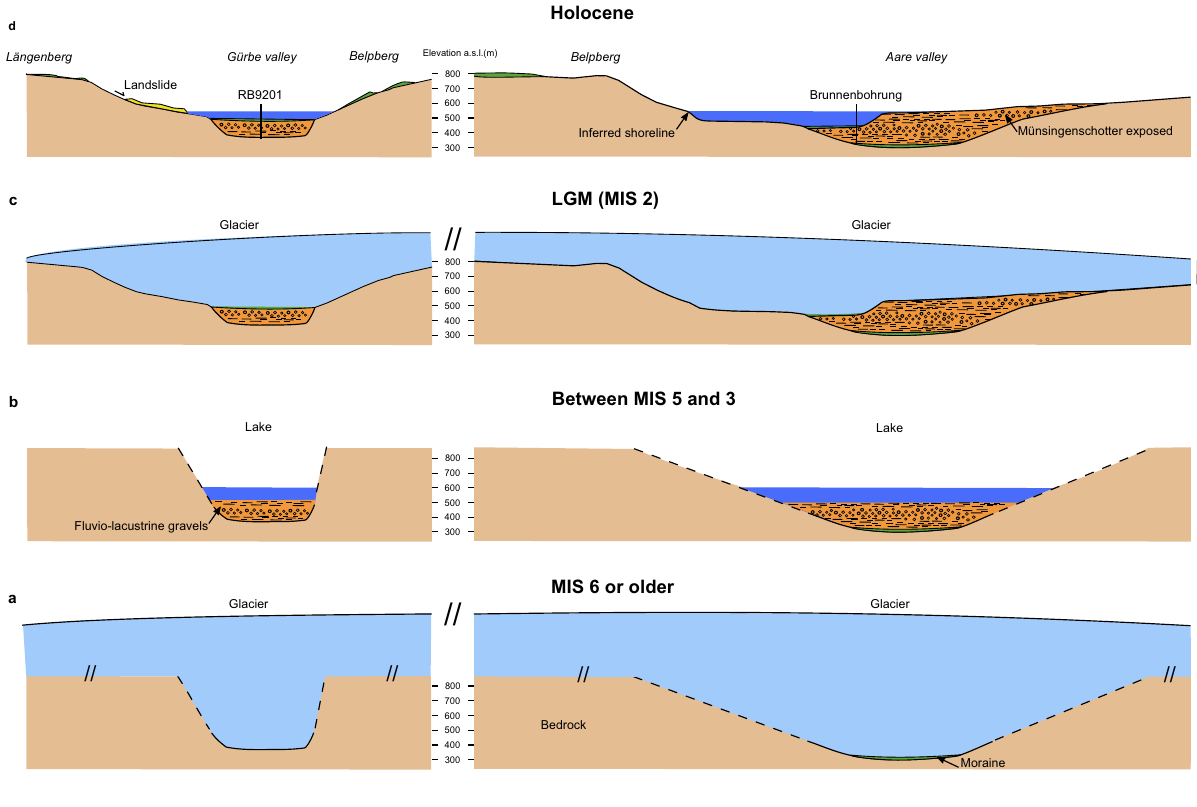
Figure 7. Evolution. Summary figure showing the evolution of the overdeepenings with various time steps in response to glacial carving ( a ) during MIS 6 or previous glaciations, ( b ) during the time between MIS 5 and MIS 3, ( c ) during the LGM time, and ( d ) during the Holocene. Please note that stage ( b ) illustrates a lacustrine phase with a lake level of ( c ). 600 m a.s.l,. The lake was most likely filled by gravel and lacustrine mud up to this elevation. The corresponding sediments are currently exposed as Münsingenschotter (Fig. 2a). This gravel unit then formed the basis of the LGM glacier as illustrated in ( c ). The early Holocene was characterized by a lacustrine phase where wave erosion made the final adjustments particularly on the eastern flank of the Belpberg. This period was also characterized by landslides particularly on the western flank of the Gürbe valley. Currently, the Aare and Gürbe valleys are occupied by